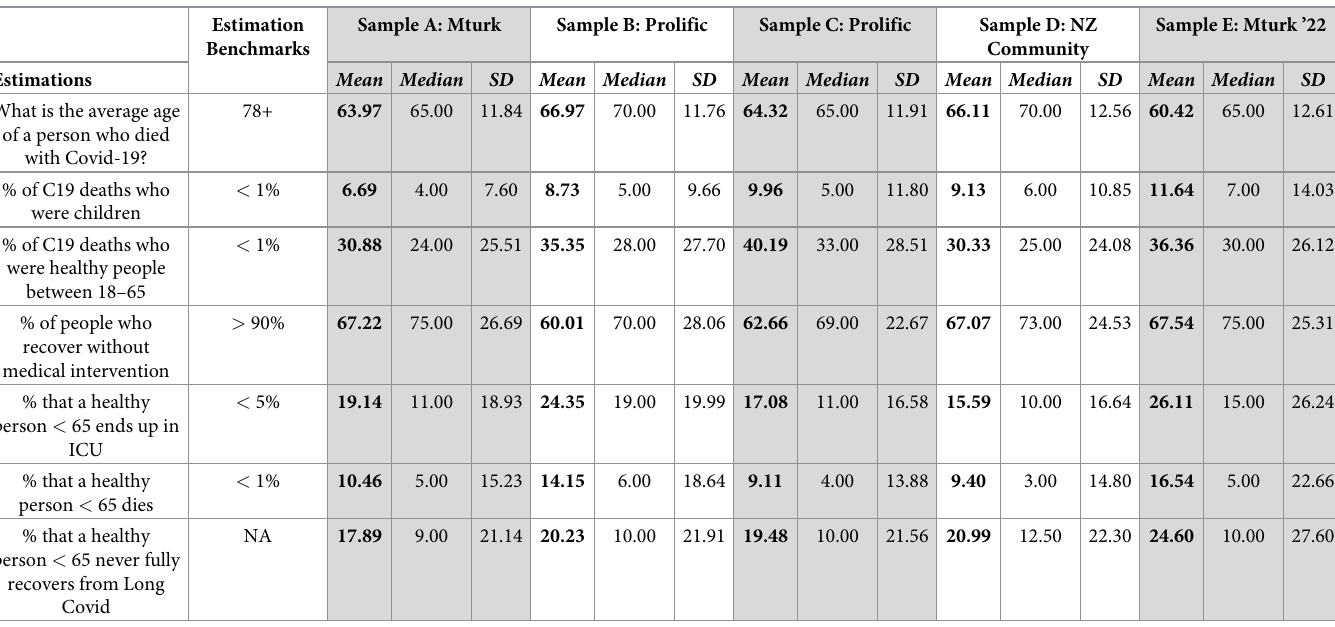
Table 7. Descriptive statistics: Estimation of negative COVID-19 consequences per